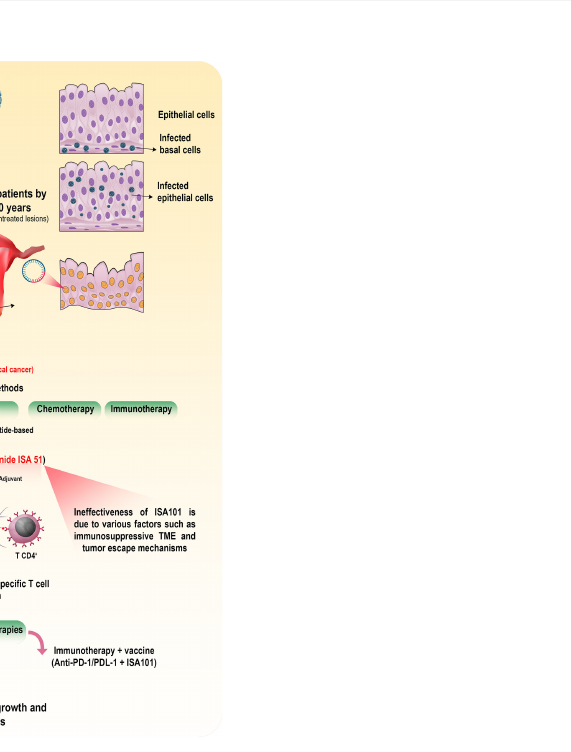
FIGURE 2 HPV-induced cervical cancer and available therapeutic approaches. Following infection with HPV-16 and HPV-18 subtypes, the basal cells in the cervix are affected, and after a few weeks, the infection spreads to the epithelial cells and HPV replicate in the cytoplasm of these cells (episomal viral DNA replication). Regularly, most people recover spontaneously after a period of one to two years. However, after 10 to 30 years, in about 0.08% of patients, persistent infections along with untreated lesions could be associated with disruption of E2 and E6/E7 oncogenes upregulation and the HPV genome integration into the host DNA, resulting in HPV-induced cervical cancer. There are various treatments such as surgery, radiotherapy, chemotherapy, and vaccination for these patients. Among the peptide-based vaccines, the ISA101 vaccine, which consists of two synthetic proteins, E6 and E7, along with Montanide ISA 51 adjuvant, can activate the speci fi c responses of T cells against HPV- infected cells. Although due to obstacles such as the immunosuppressive TME and other unknown reasons, this vaccine is not effective. Therefore, combining of chemotherapy and other immunotherapeutic approaches, such as immune checkpoint blockers with ISA101 could be more effective than ISA101 monotherapy for advanced cervical cancer.